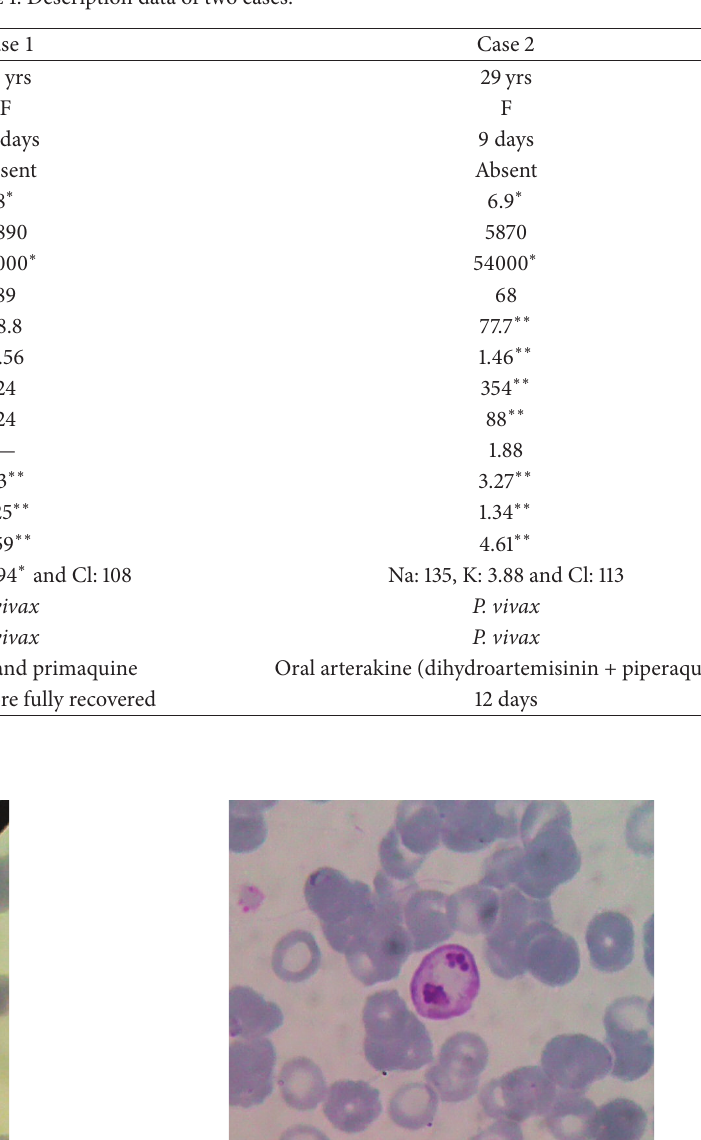
Table 1: Description data of two cases.